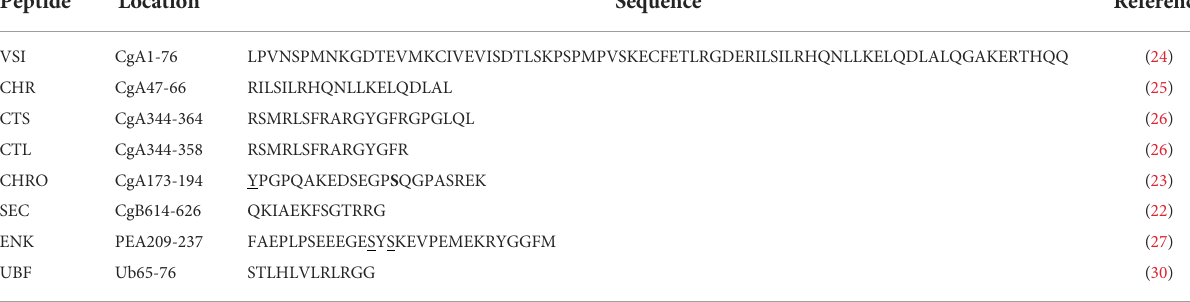
TABLE 1 Characteristics of the different AMPs derived from CgA, CgB, PEA and